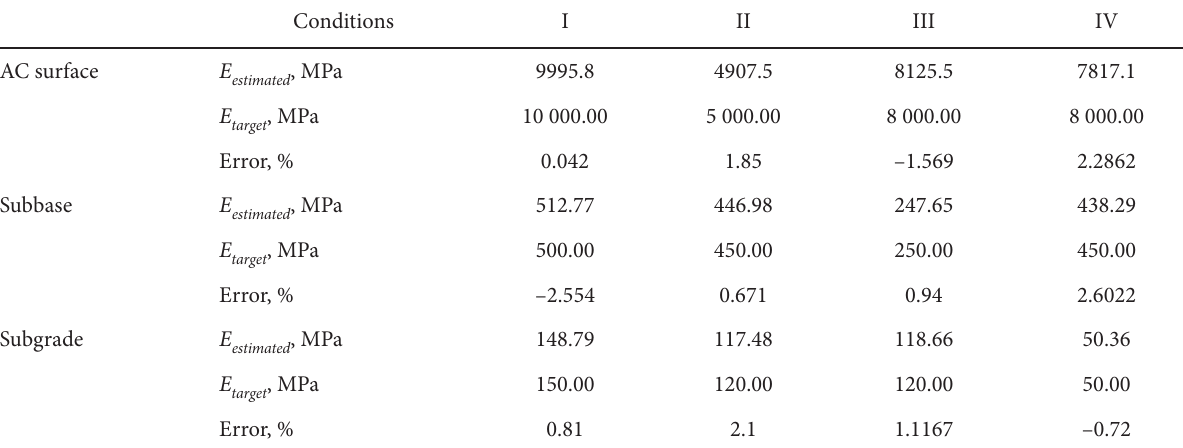
Table 3. Estimation results by NN without modeling error for half space boundary